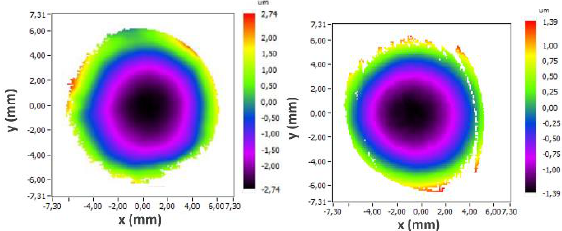
Figure 1 : Wavefront distortion measurment of 0.5%Nd: 5%Lu : CaF 2 at 10 Hz repetition rate (left) and Nd :Phosphate at 4 Hz repetition rate (right)